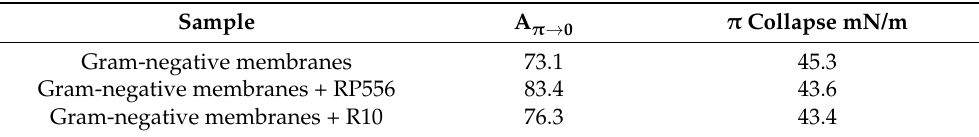
Figure 6. Localization of π –A isotherms for Gram-membrane model mixtures with peptides RP556 and R10. Table 5. A π → 0 and π -collapse values of Gram-negative membrane and membrane peptide mixtures derived from π -A isotherms.